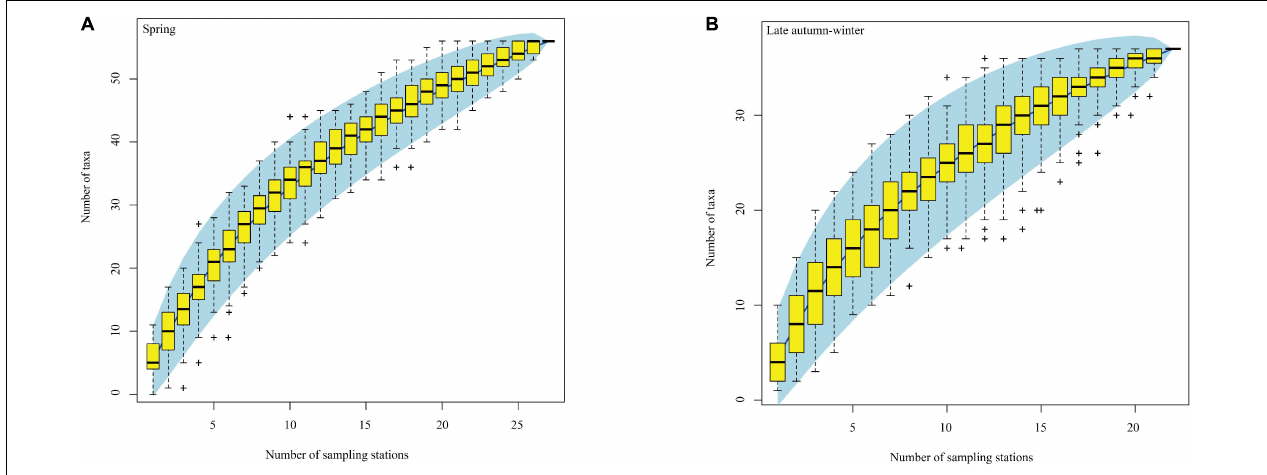
FIGURE 5 | Species accumulation curves of fish eggs taxa identified by molecular methods in the eastern Beibu Gulf. (A) Spring; (B) late autumn-winter. The light blue area indicates 95% confidence intervals. Yellow boxes are the interquartile ranges, the central bold mark on each box indicates the median, and the bottom and top edges of the box indicate the 25th and 75th percentiles, respectively. The whiskers extend to the most extreme data points not considered outliers, and the outliers are plotted individually using the “+”symbol.